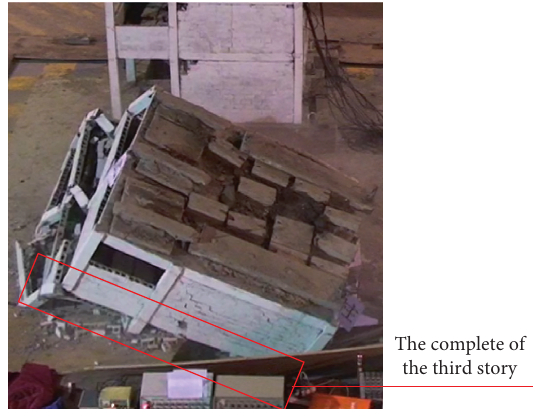
Figure 42: Third-floor collapse of the test (right). Figure 43: Third-floor collapse of the simulation